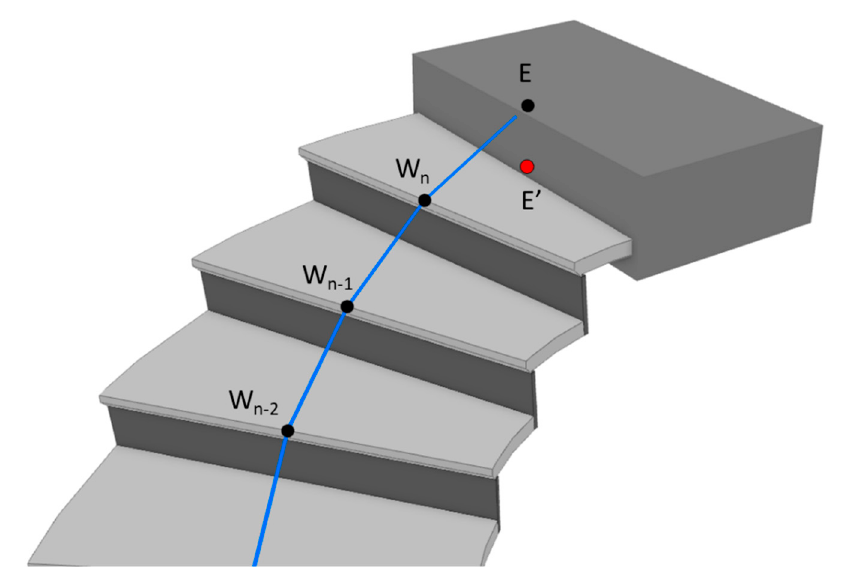
Figure 15. Illustration of the method for determining the path end.